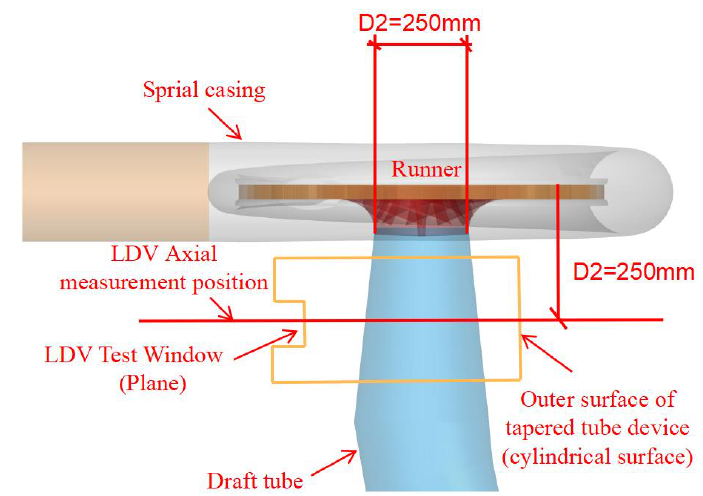
Figure 1. LDV test location of the model test.